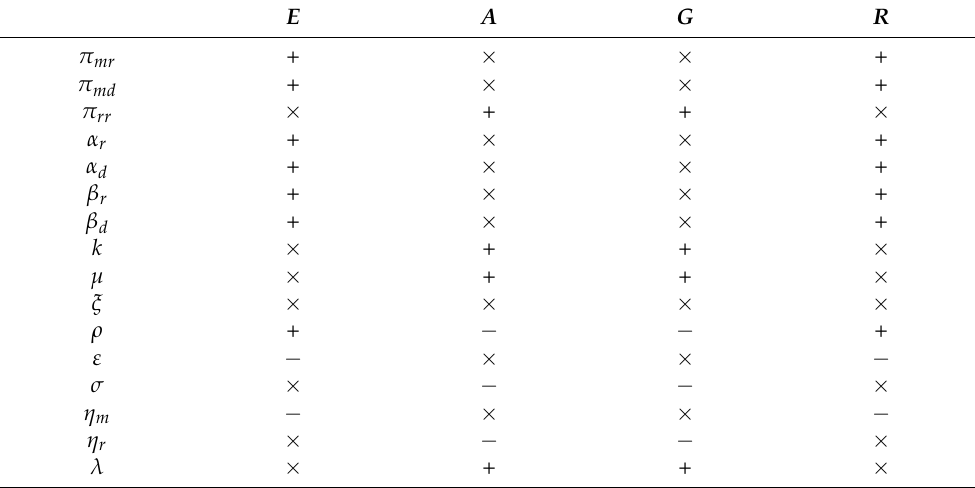
Table 3. Comparative static analysis of parameters under decentralized decision